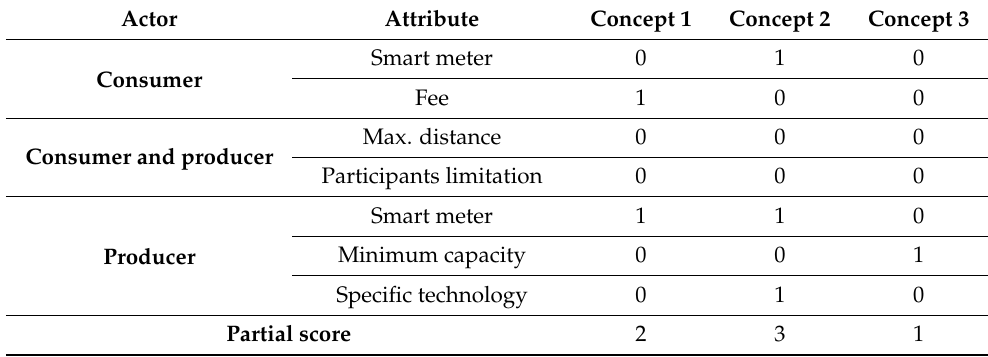
Table 12. Entry barrier—first partial score. Attributes affecting the main actors in the P2P-ET. Actor